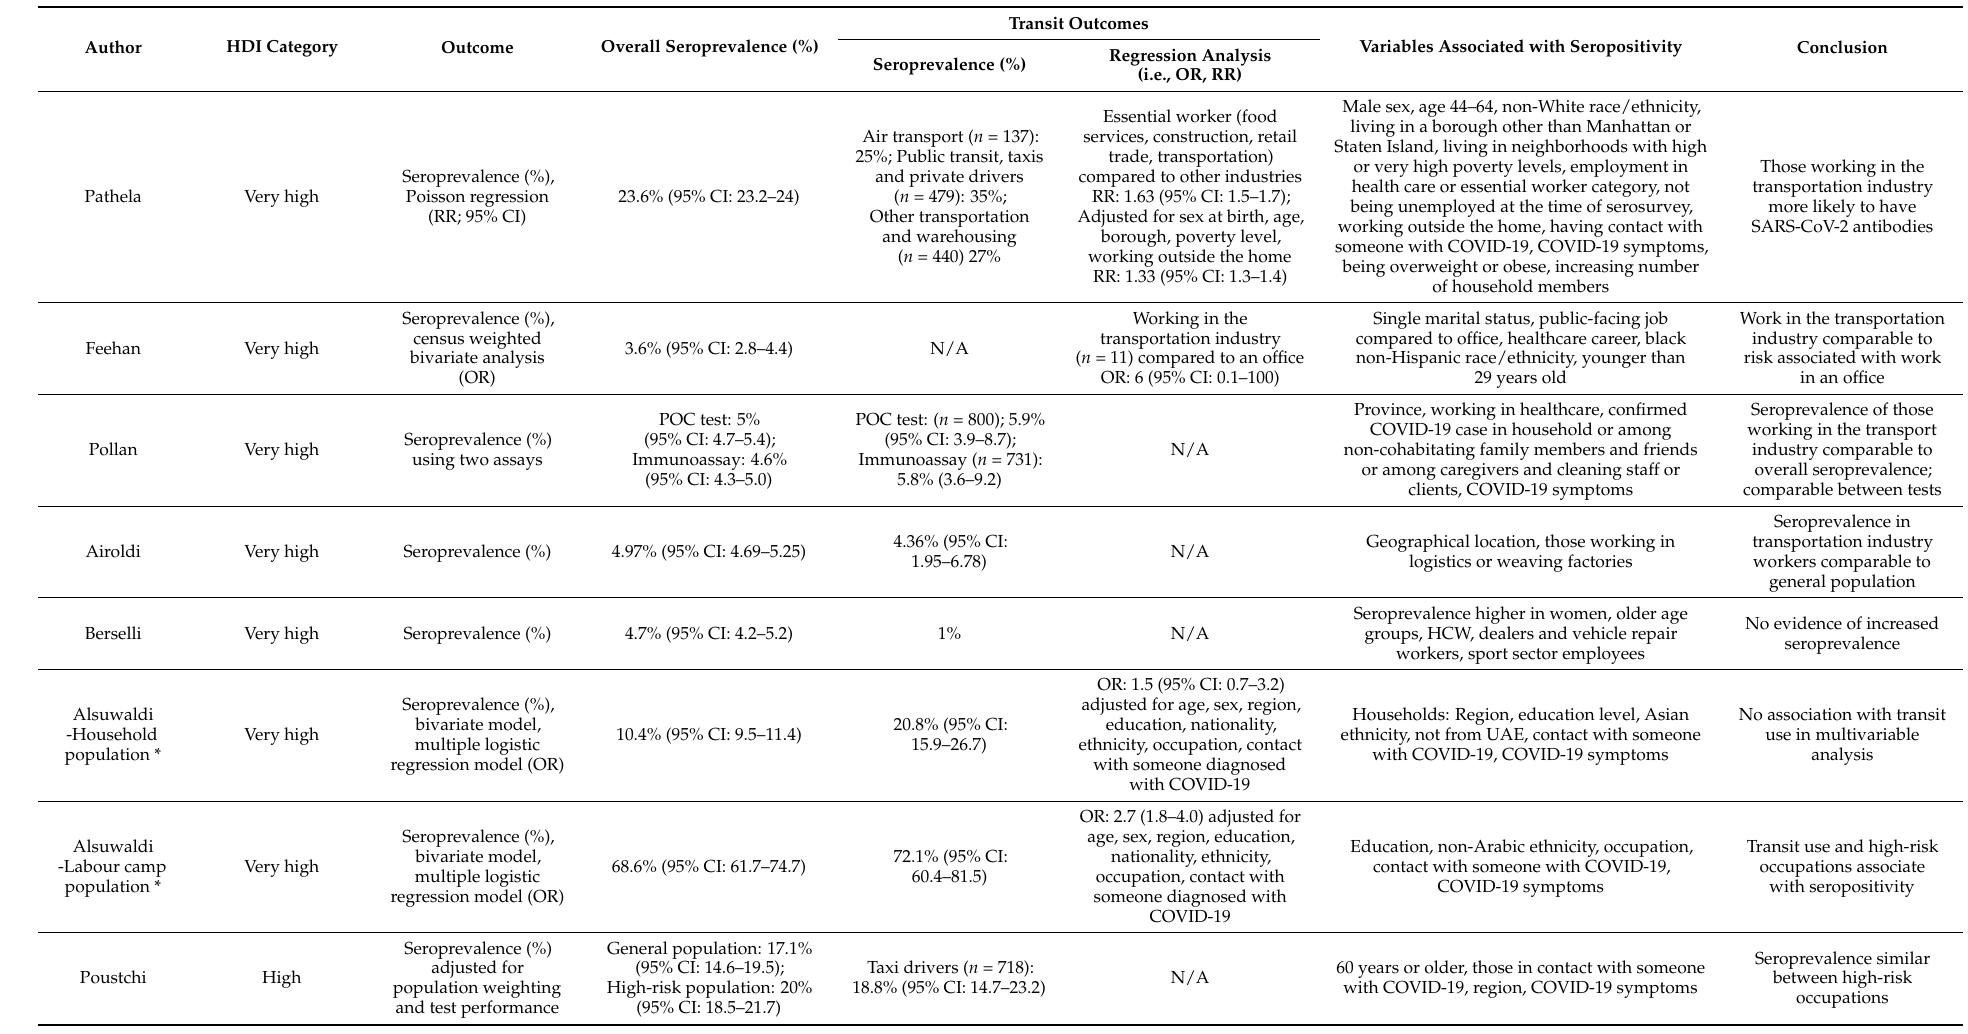
Table 2. Summary of findings from studies that assessed the association between seropositivity and work in the transportation industry from highest to lowest